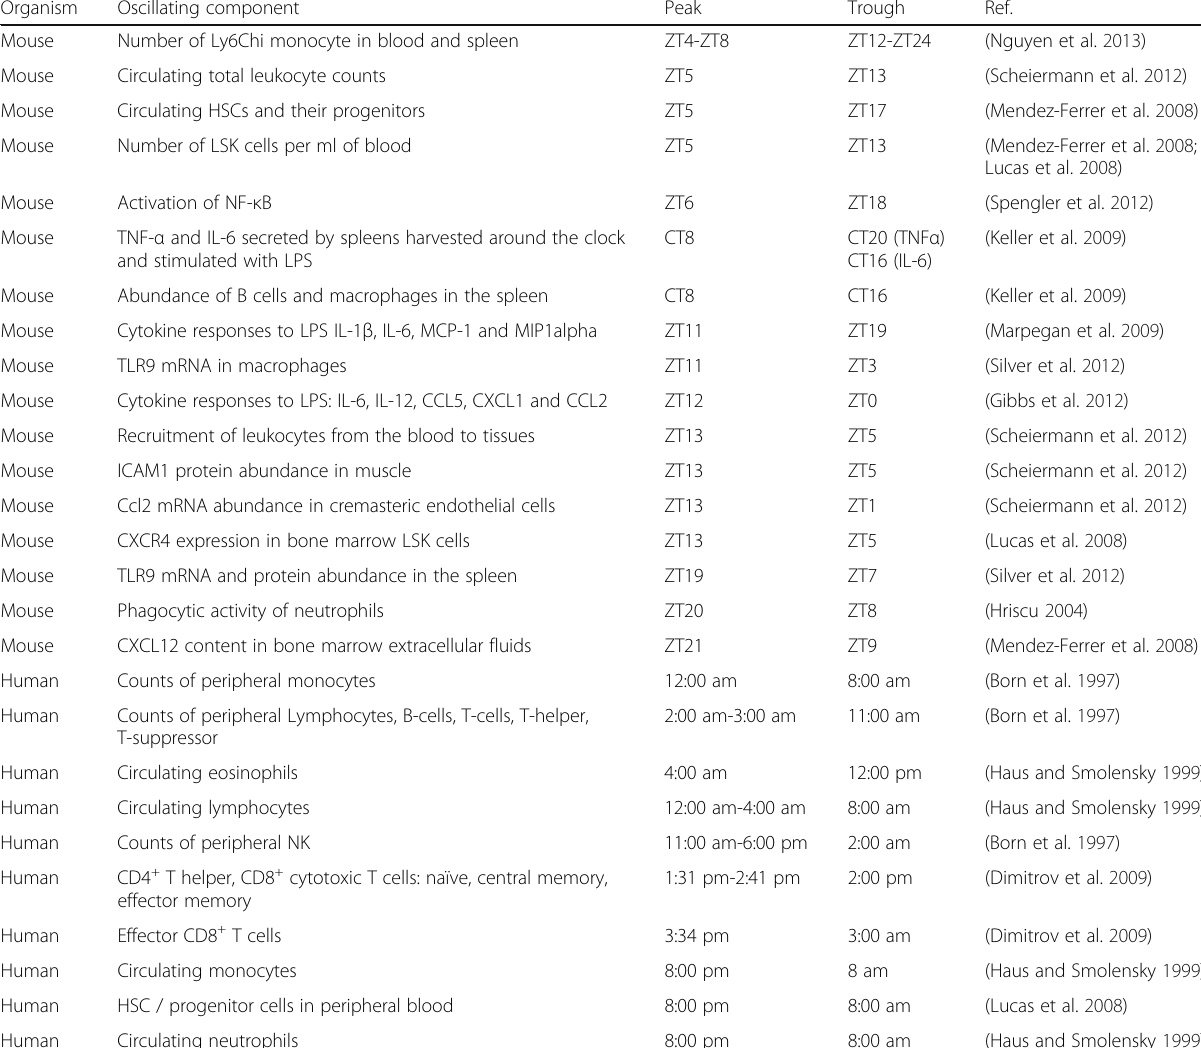
Table 1 Examples of circadian rhythms in the immune system and the correspondent peaks and troughs of these oscillations Organism Oscillating component Peak